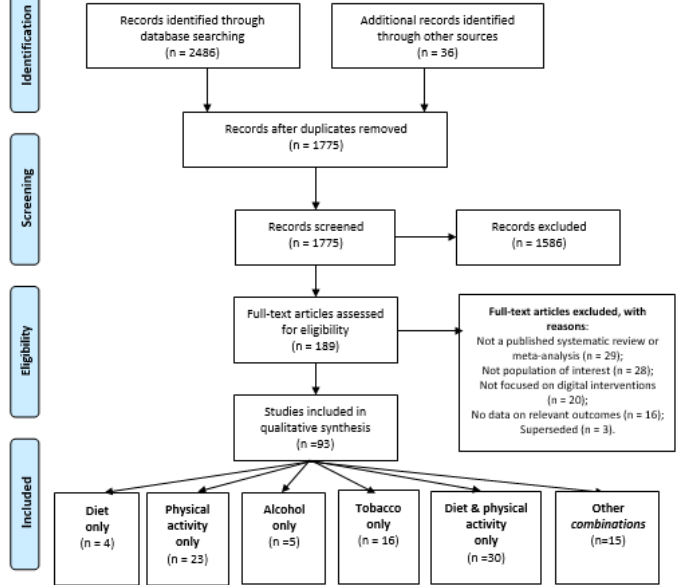
Figure 1. PRISMA flowchart. PRISMA: Preferred Reporting Items for Systematic Reviews and